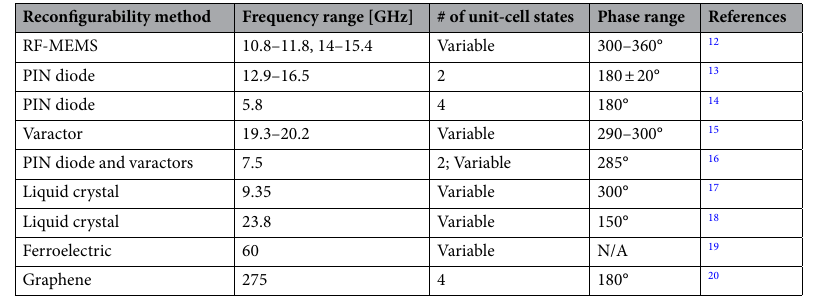
Table 1. Properties of recently proposed